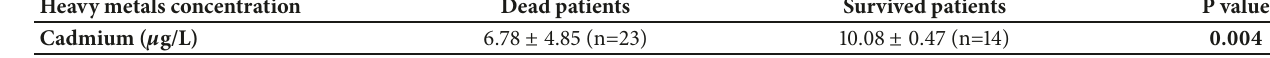
(a) Cadmium concentration in dead and survived